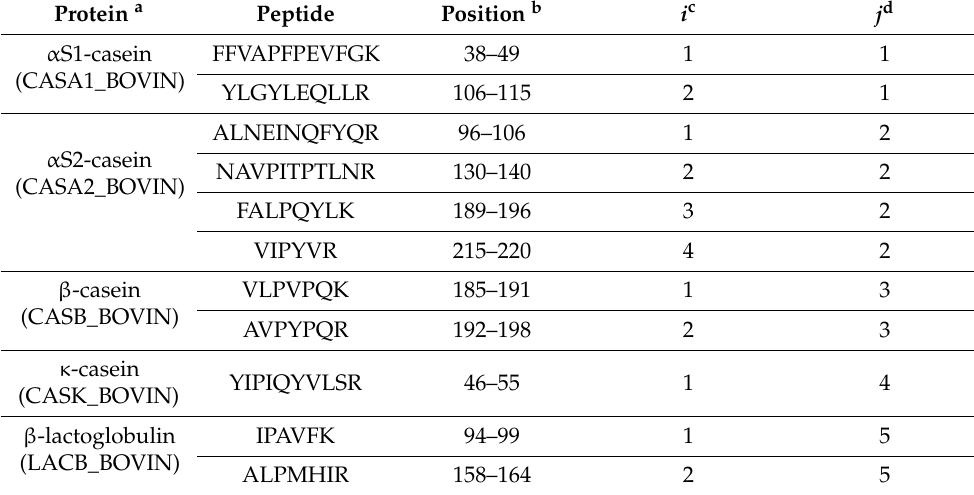
Table 1. List of the 11 proteotypic peptides of five major constituent proteins of